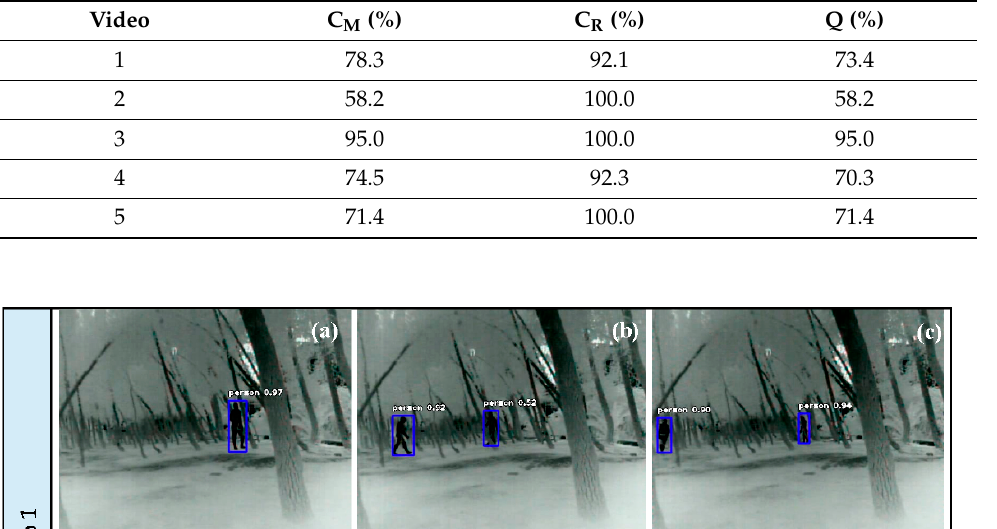
Table 4. Quantitative object detection results for terrestrial asset using the thermal camera and applying the pretrained YOLOv3